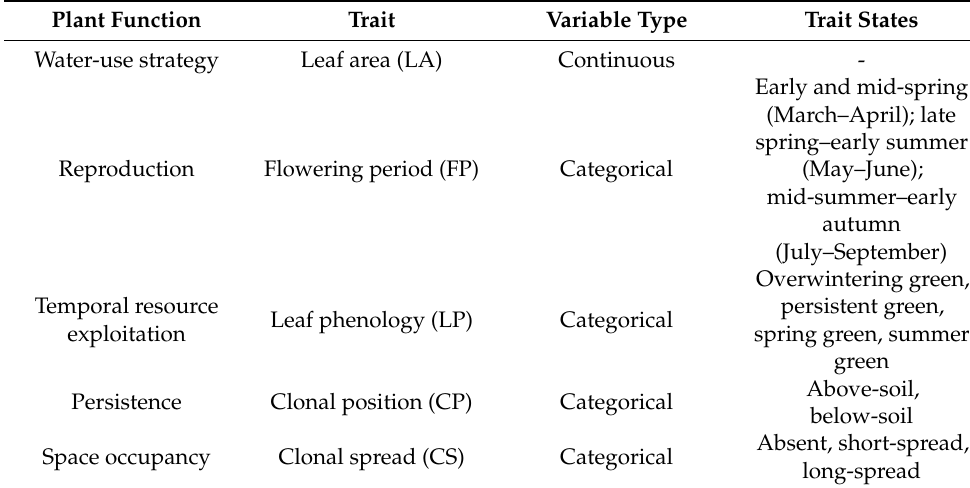
Table 1. Cont. Plant Function Trait Variable Type Trait States Water-use strategy Leaf area (LA) Continuous -